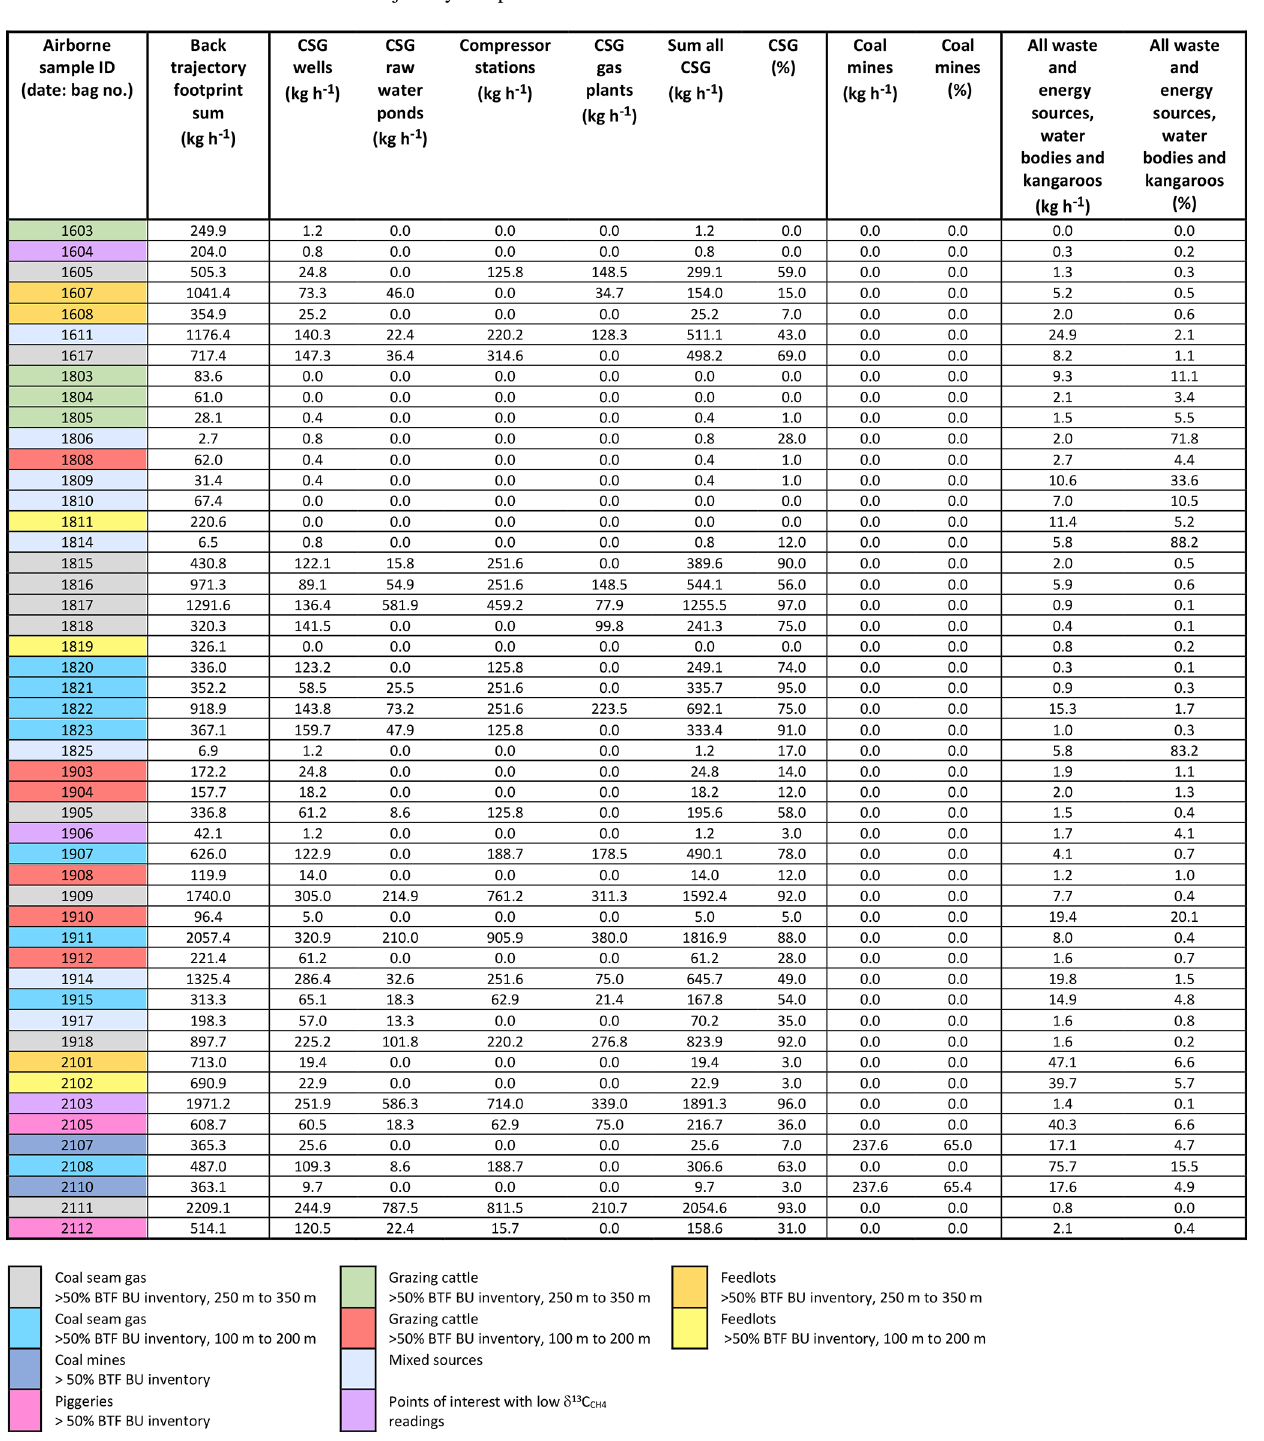
Table A3. In-flight atmospheric air sample location details and UNSW bottom–up inventory CH 4 emissions estimates for fossil fuel and minor mixed sources within the 2h back-trajectory